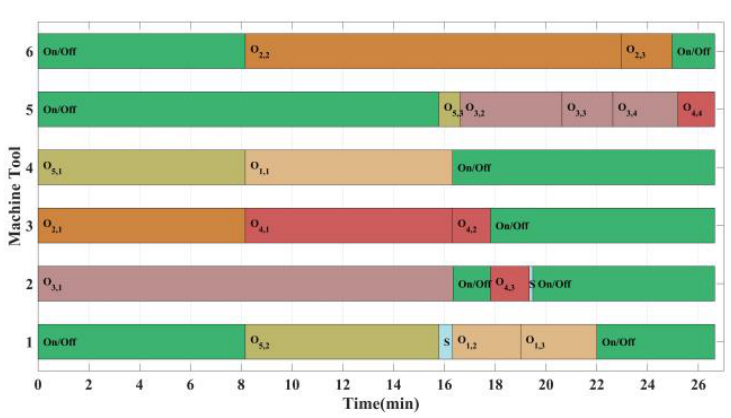
Figure 23. Gantt chart of scheme 1.